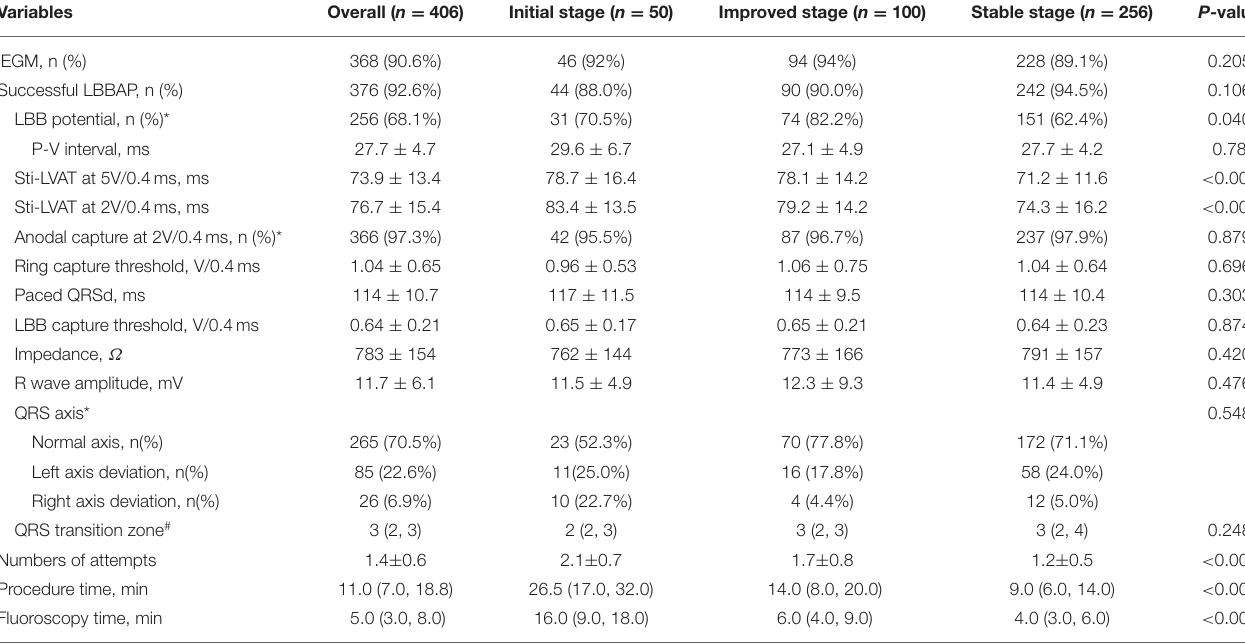
TABLE 2 | Pacing and procedural parameters in patients attempting LBBAP.